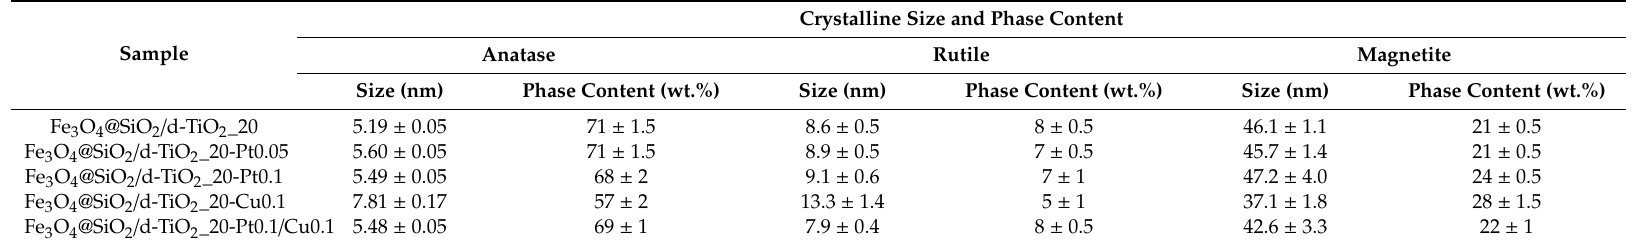
Table 4. Crystalline phases characteristic for the obtained magnetic Fe 3 O 4 @SiO 2 / d-TiO 2 _20-Pt / Cu